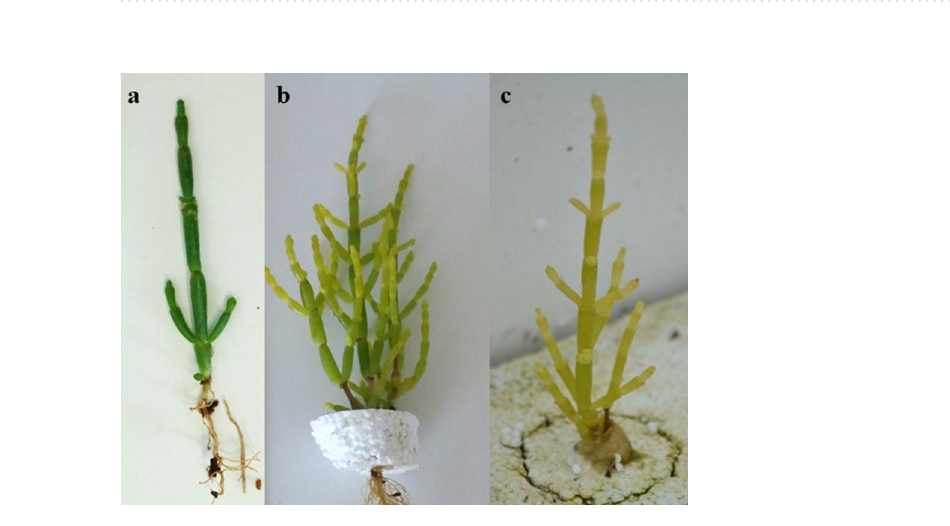
Figure 7. Evolution of coloration of Salicornia ramosissima over the experimental period: ( a ) plants at day 1; ( b ) plants at day 30 and ( c ) plants at day